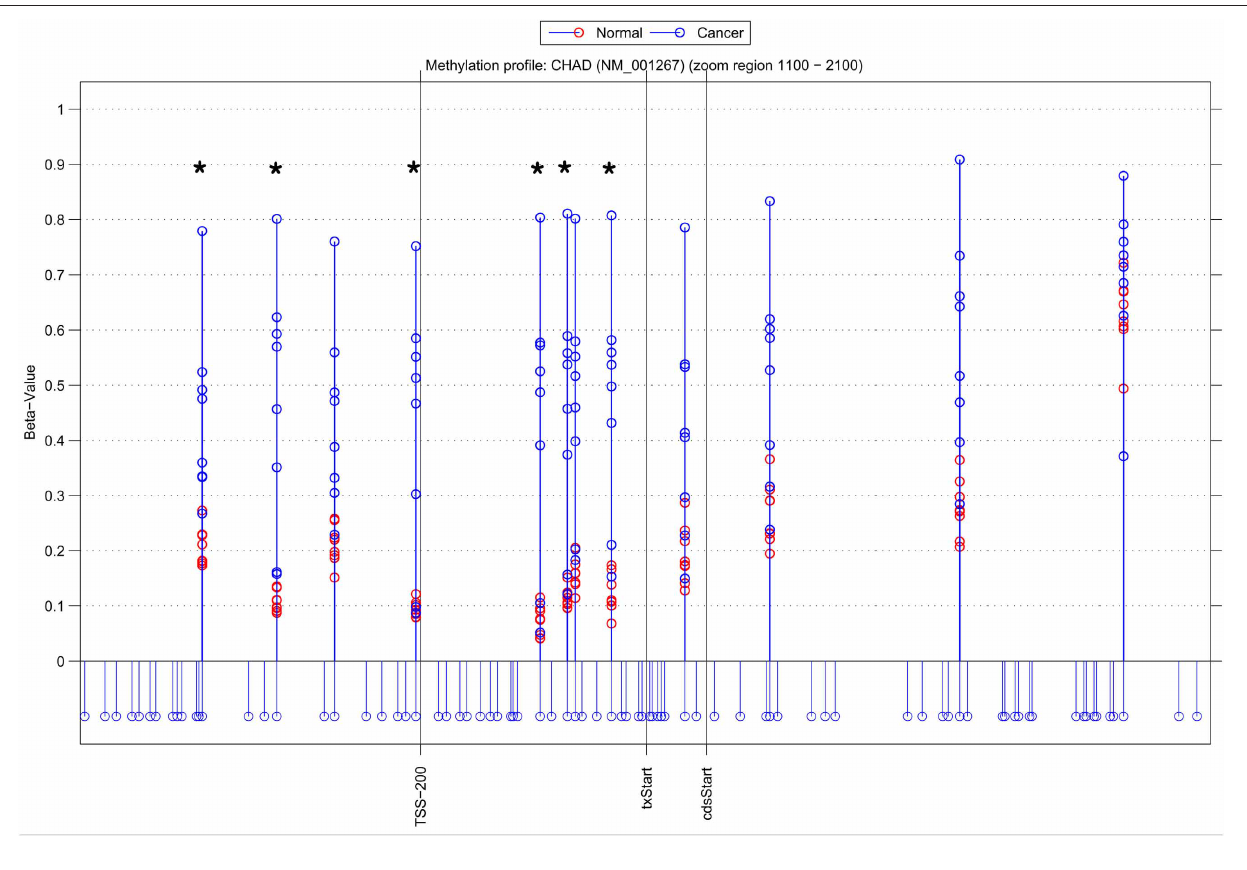
region. CpG sites identified as differentially methylated by NIMBL [ d = 0 . 1 , m = 2] are highlighted with asterisks. Abbreviations: TSS200, position 200bp upstream of transcriptional start site (txStart); cdsStart, coding sequence start.